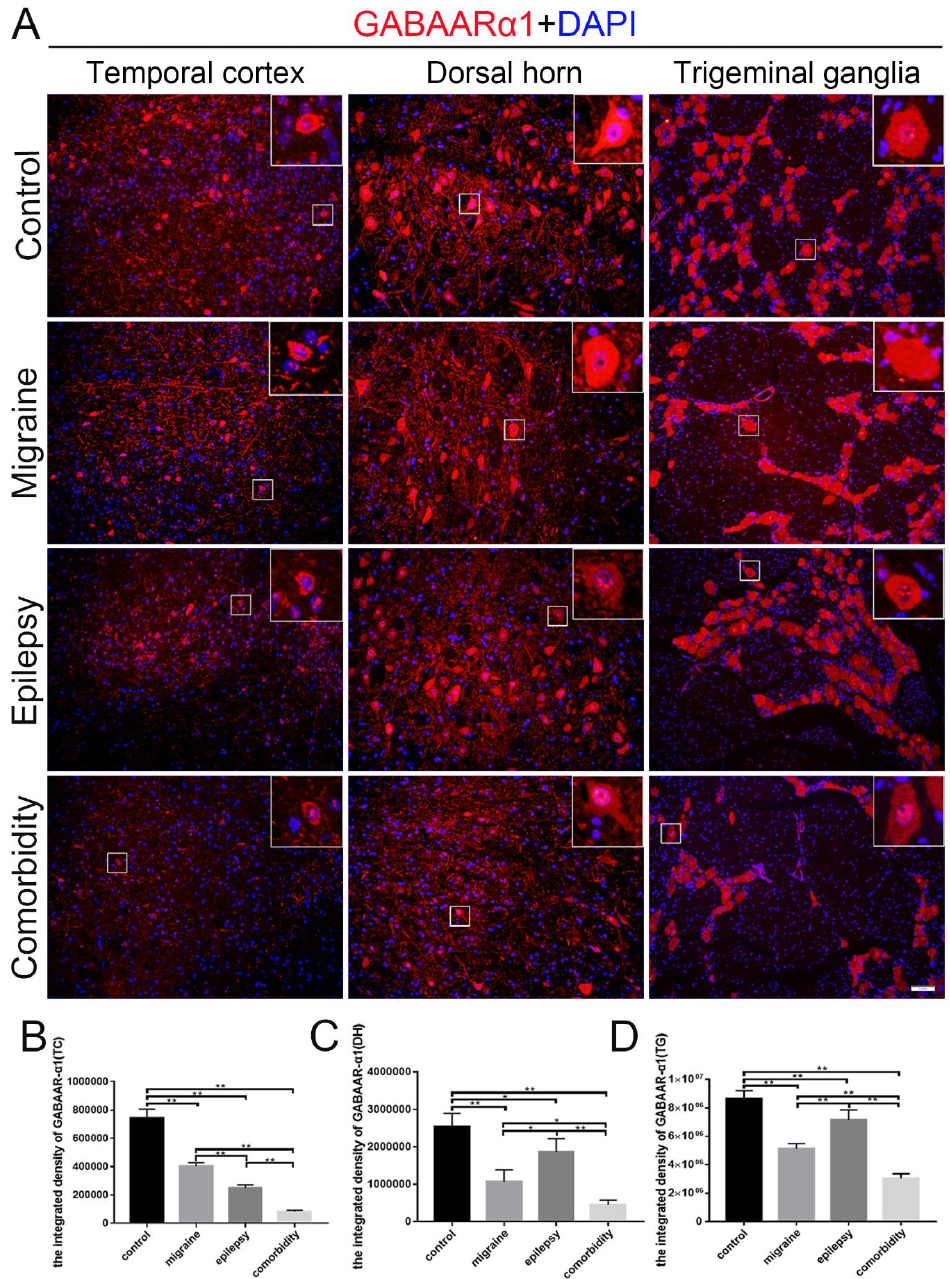
Figure 3. Localization of GABAAR α 1 in the temporal cortex, medullary dorsal horn, and trigeminal ganglion in four groups. ( A ) GABAAR α 1 (red) localized in the temporal cortex, medullary dorsal horn, and trigeminal ganglion in four groups. GABAAR α 1 was expressed in both the cytoplasm and the nucleus ( A , magnifying cells). ( B – D ) Quantitative assessment of the integrated density of GABAAR α 1 in temporal cortex ( B ), medullary dorsal horn ( C ), and trigeminal ganglion ( D ) ( n = 3, * p < 0.05, ** p < 0.01). DAPI (blue) indicates cell nuclei. The scale bar represents 50 µ m. TC: temporal cortex, DH: medullary dorsal horn, TG: trigeminal